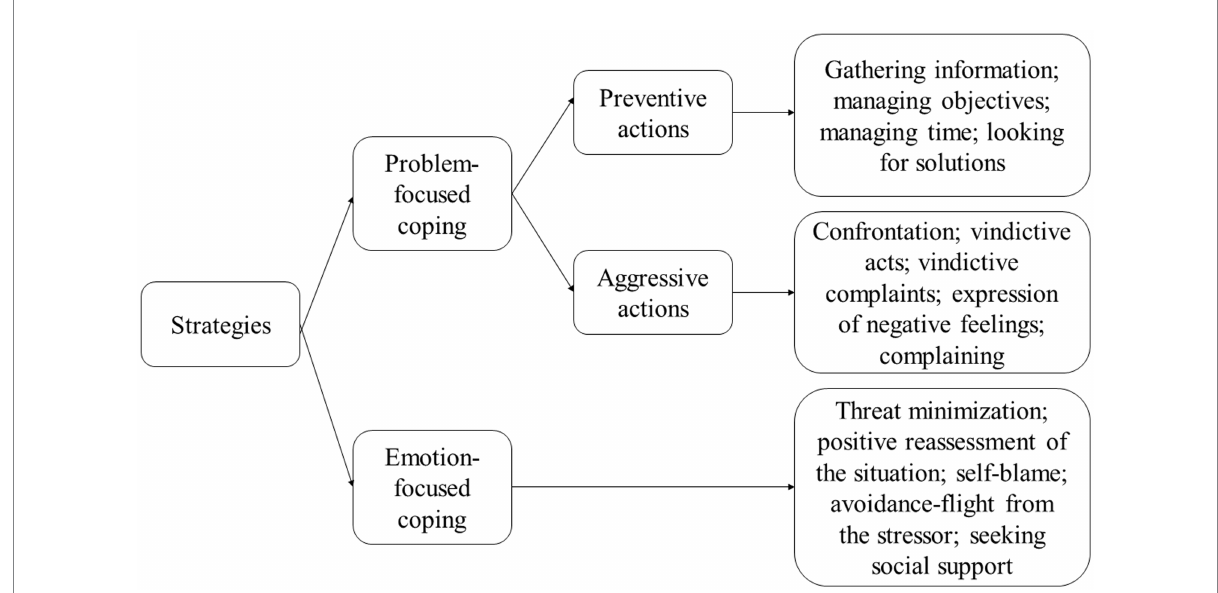
FIGURE 1 Coping strategies. Drawn using source data from Lazarus and Folkman